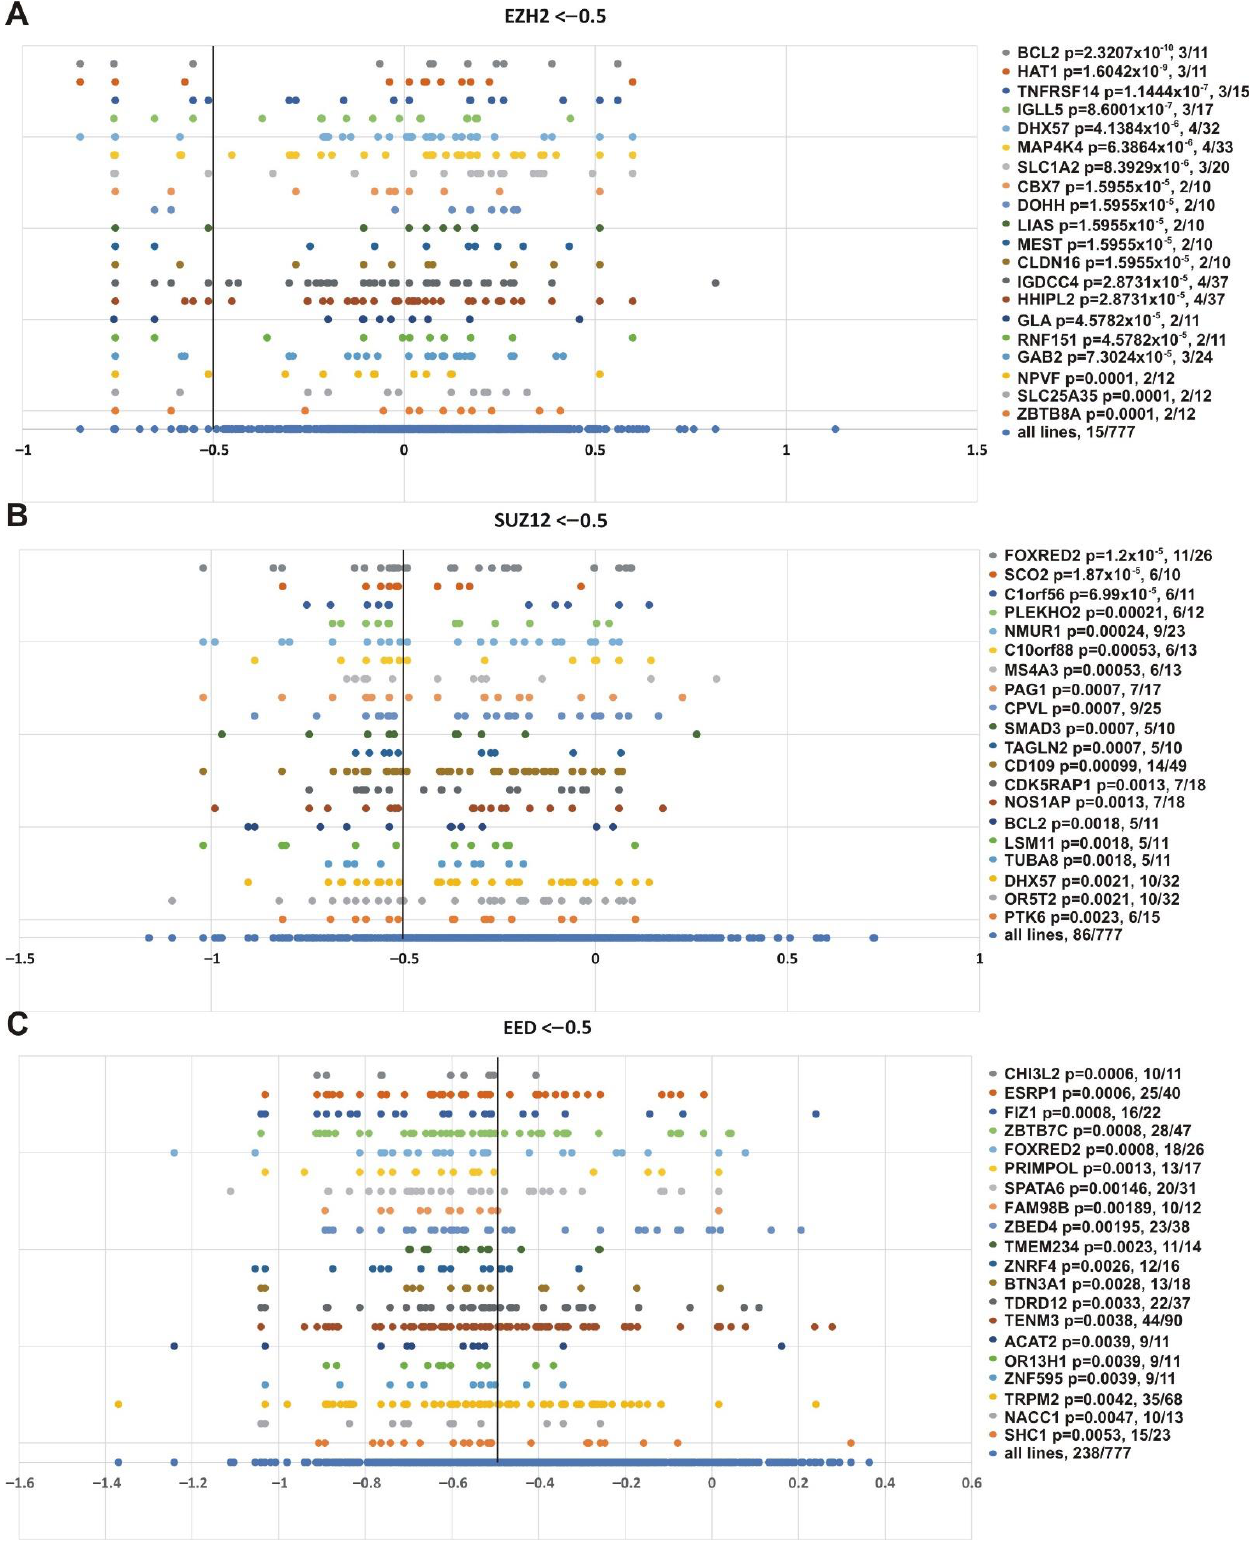
Figure 9. Top 20 genes showing the best correlation with the sensitivity of cancer cell lines to PRC2 genes knockout. ( A ) EZH2 , ( B ) SUZ12 and ( C ) EED. Other designations as in Figure 8.